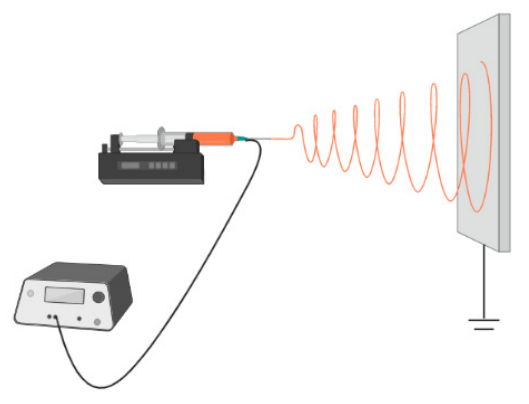
Figure 5. Schematic of the electrospinning process.